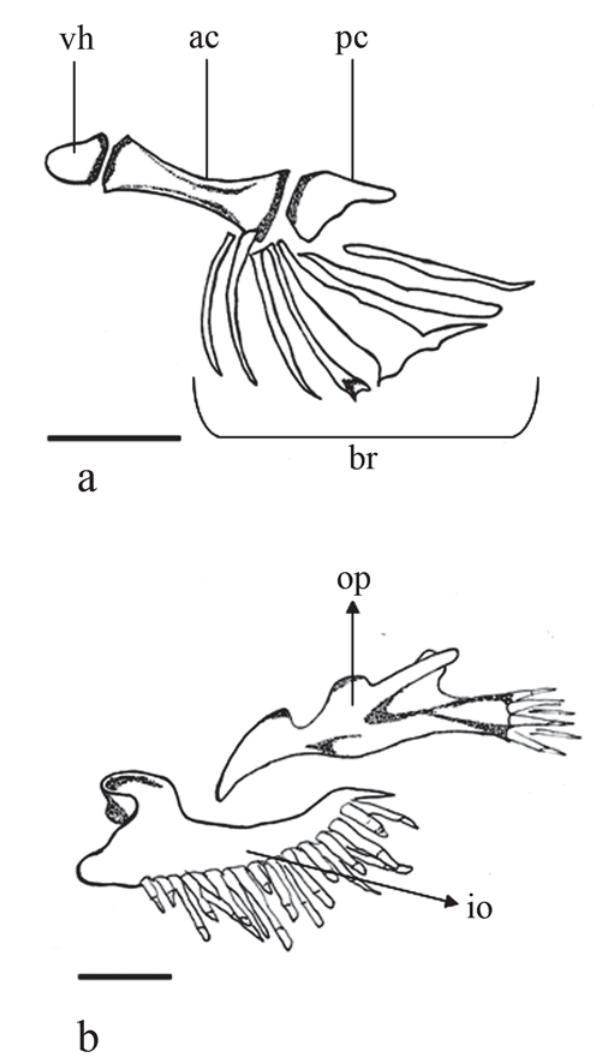
Fig. 5. a. Left hyoid arch of Trichomycterus uisae in ventral view. CAC-CDMB 90, 32.1 mm SL. ac: anterior ceratohyal; br: branchiostegal rays; pc: posterior ceratohyal; vh: hypohyal. b. Opercular series of Trichomycterus uisae. op: opercle; io: interopercle. Scale bar = 1 mm.